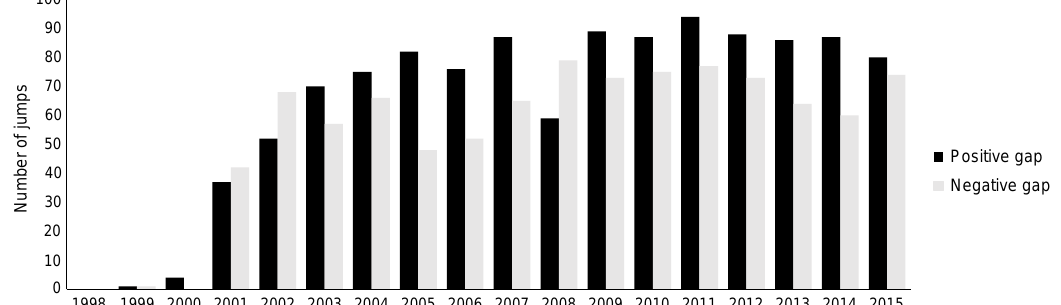
Figure 2. Development of positive and negative overnight gaps, which were identified by the BNS jump test, from